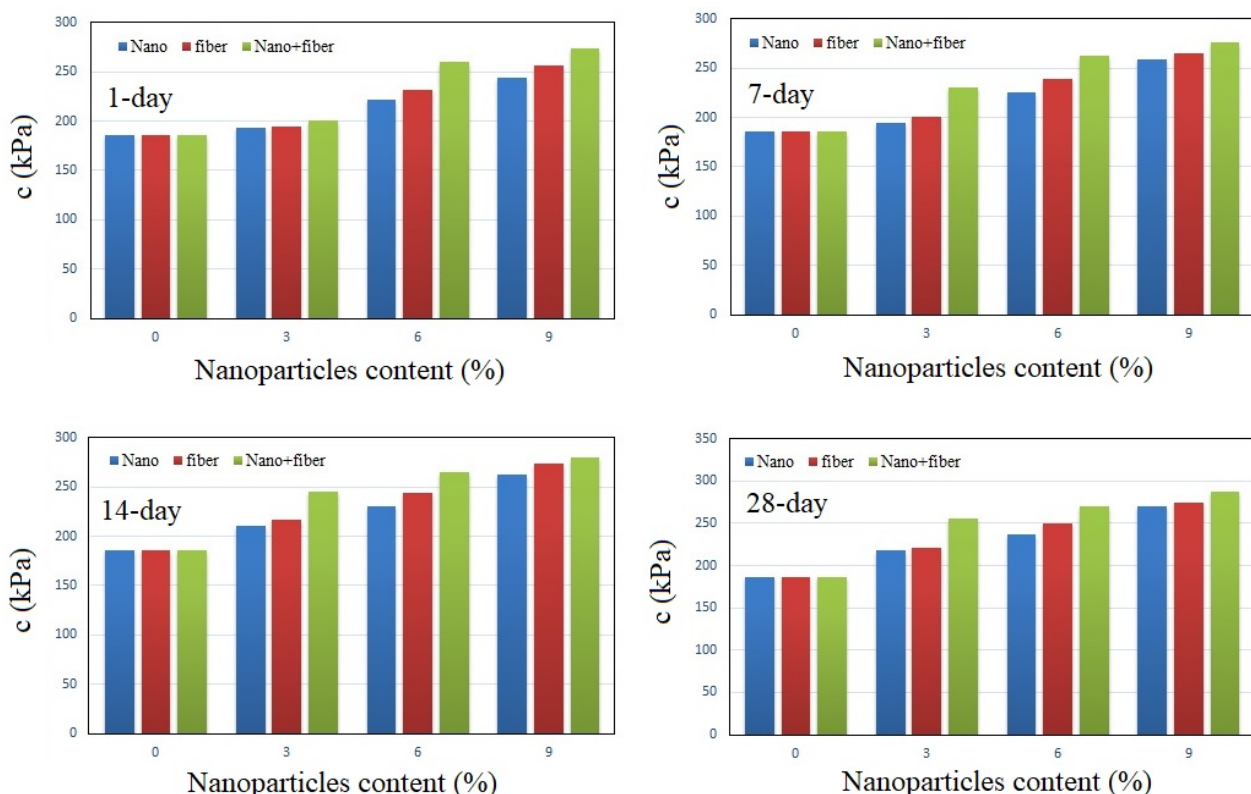
Figure 10. Estimated cohesion for a different group of the samples.